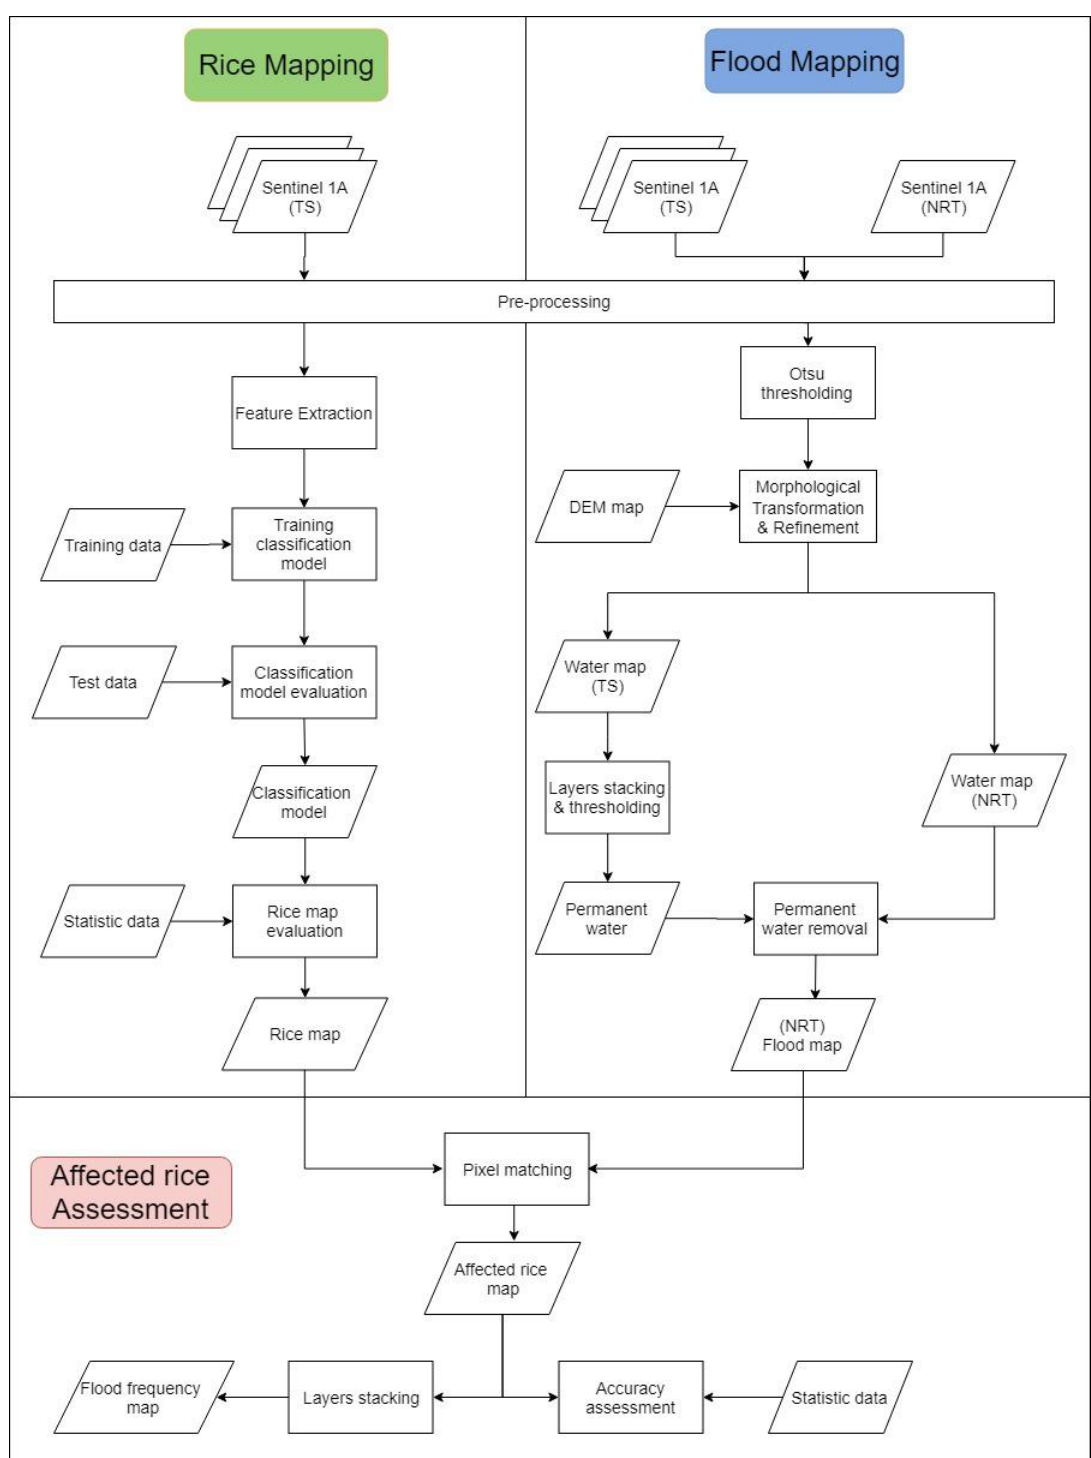
Figure 3. Overall flow chart of the study